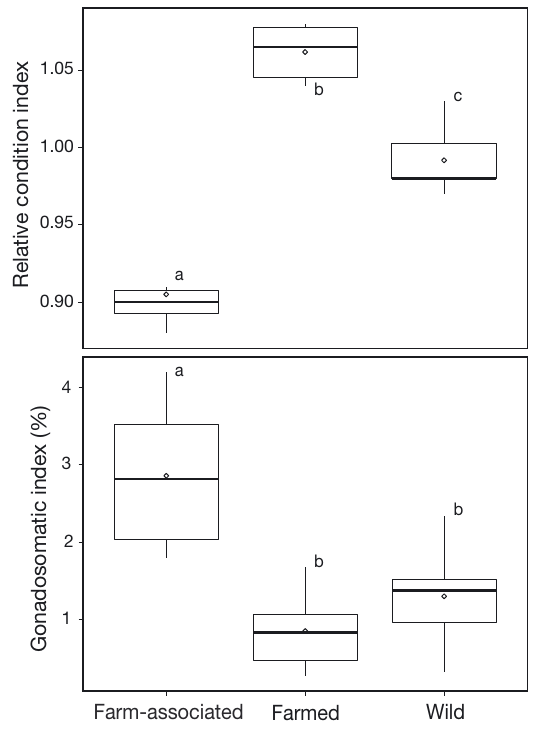
Fig. 5. Relative condition and gonadosomatic index of gilt- head seabream. Same letters denote pairwise comparisons that are not statistically